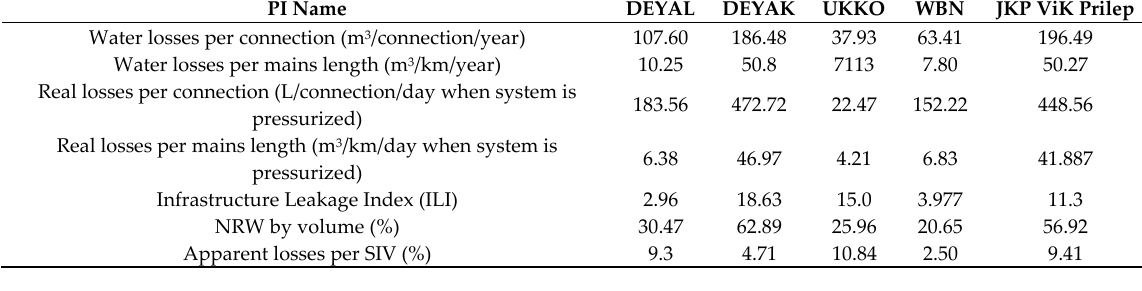
Table 4. PIs in water utilities involved.